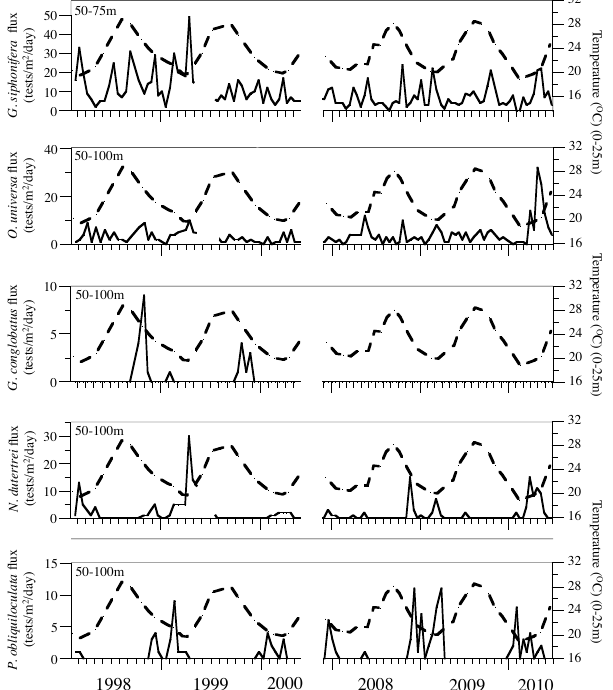
Figure 6. Temporal changes in intermediate-dwelling planktonic foraminifera fluxes in the 1500m trap with changes in sea surface temperature (0–25m) for reference. The approximate depth habitat (Anand et al., 2003) is shown in figures.